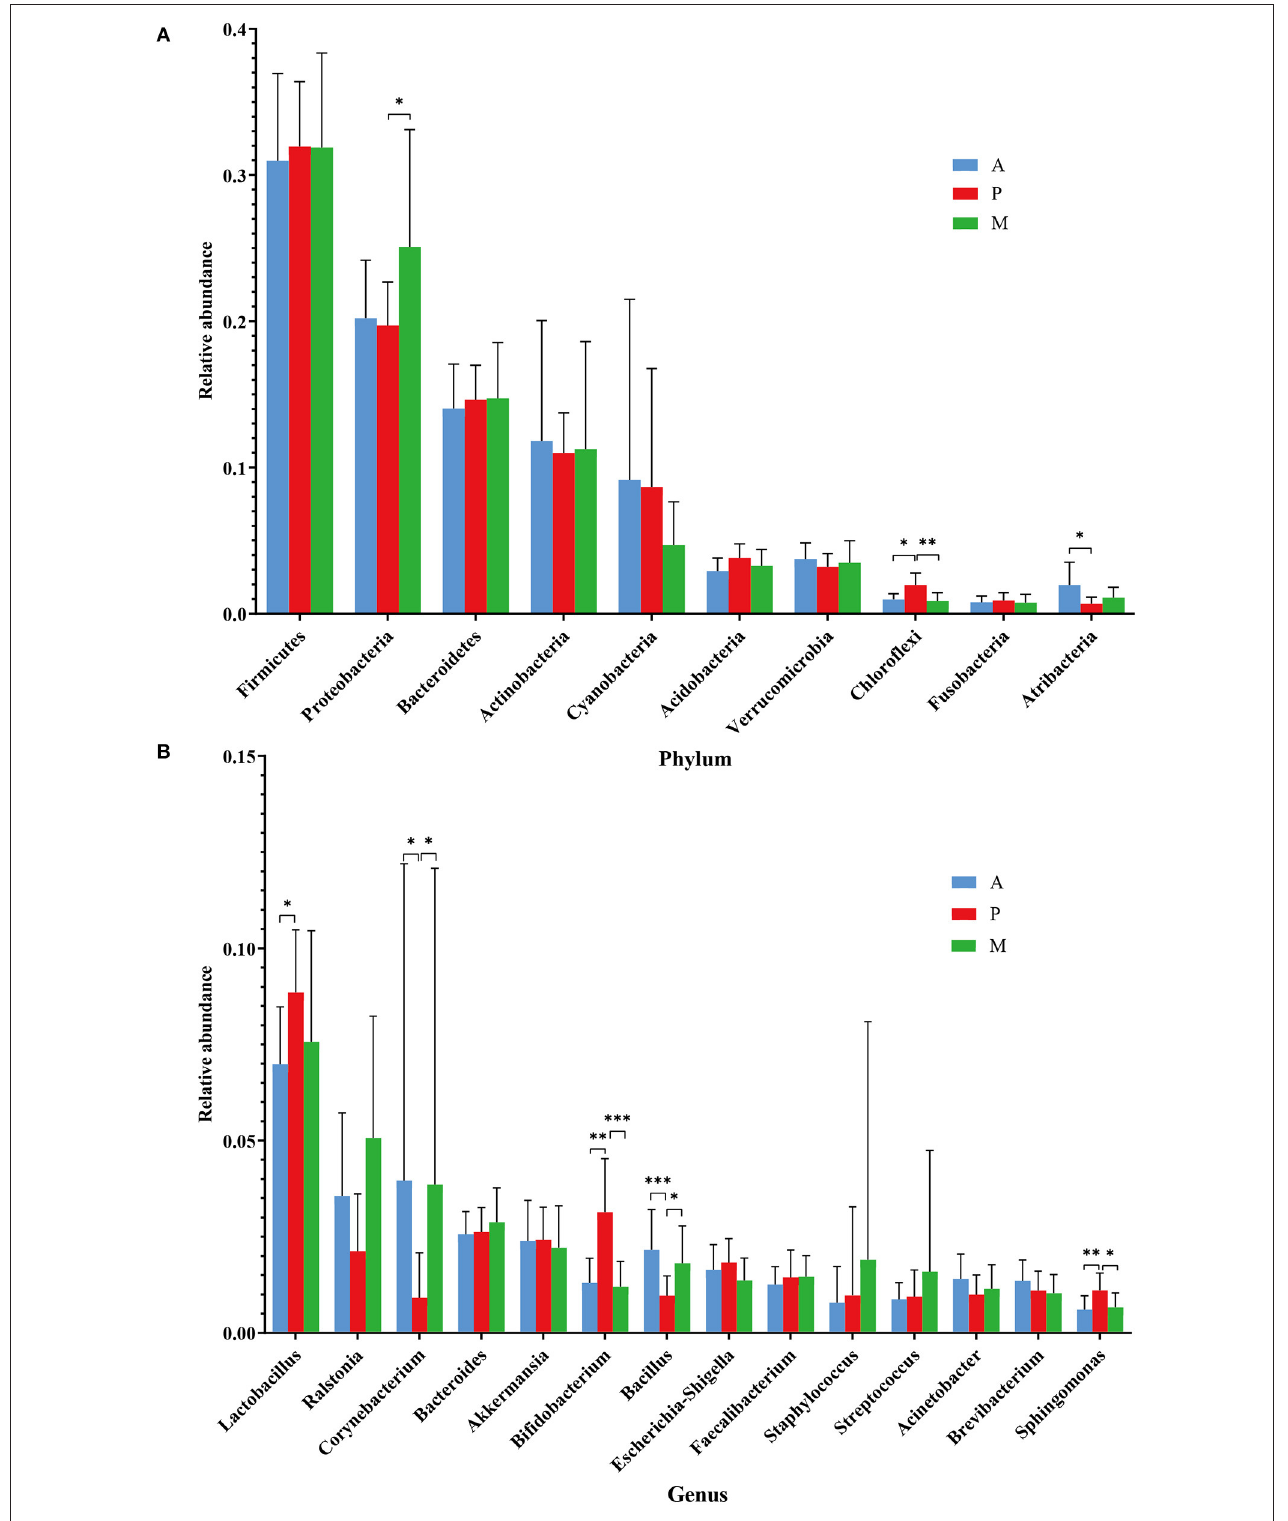
FIGURE 5 | Differences in microbiota composition in the four groups. (A, B) At the phylum and genus levels, there were significant differences in the abundances of ocular surface microbiota among the anterior blepharitis group (A), posterior blepharitis group (P) and mixed blepharitis group (M). * P < 0.05, ** P < 0.01, *** P < 0.001.